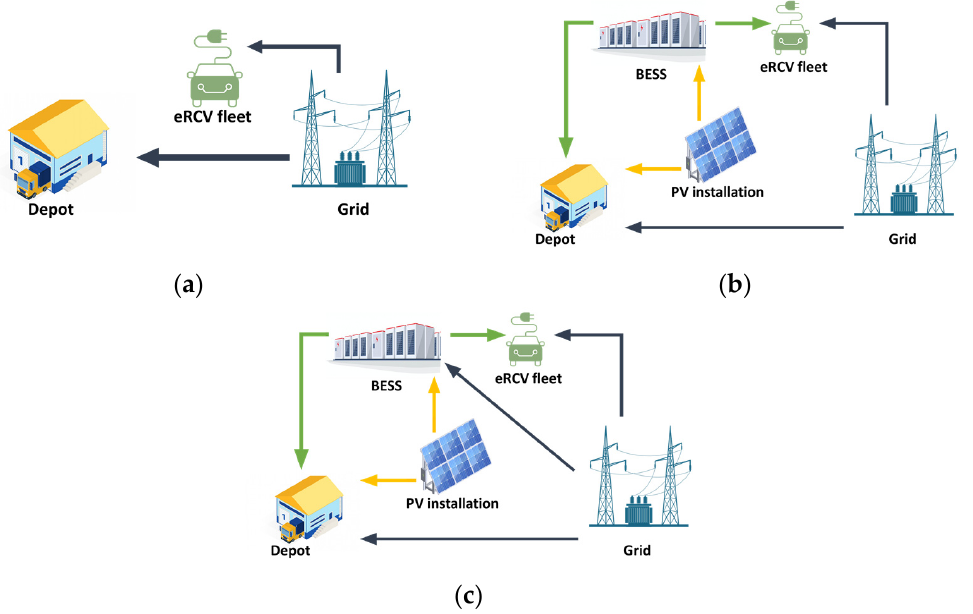
Figure 1. Energy fl ow diagram for ( a ) scenario 1, ( b ) scenario 2 and, ( c ) scenario 3. With the objective of facilitating an economic comparison between the three scenar- ios, the analysis for scenario 1 is performed using both power connection capacities, 0.15 MW and 0.6 MW. Table 1 summarises the scenarios studied, and the power connection capacity assumed for each. Table 1. Summarise of the scenarios under study and the approach used for the costs analysis. Power Connection Capacity (0.15 MW)